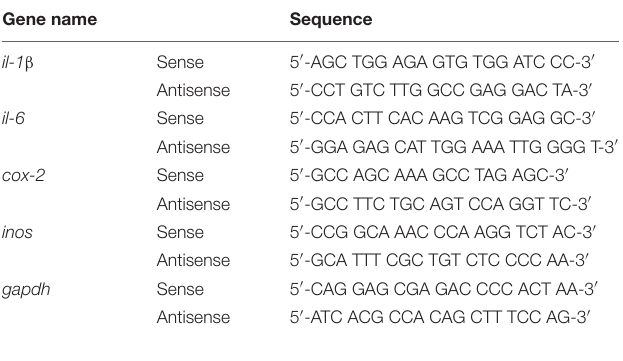
TABLE 2 | Sequences of primers used for reverse transcription-polymerase chain reaction (RT-PCR).